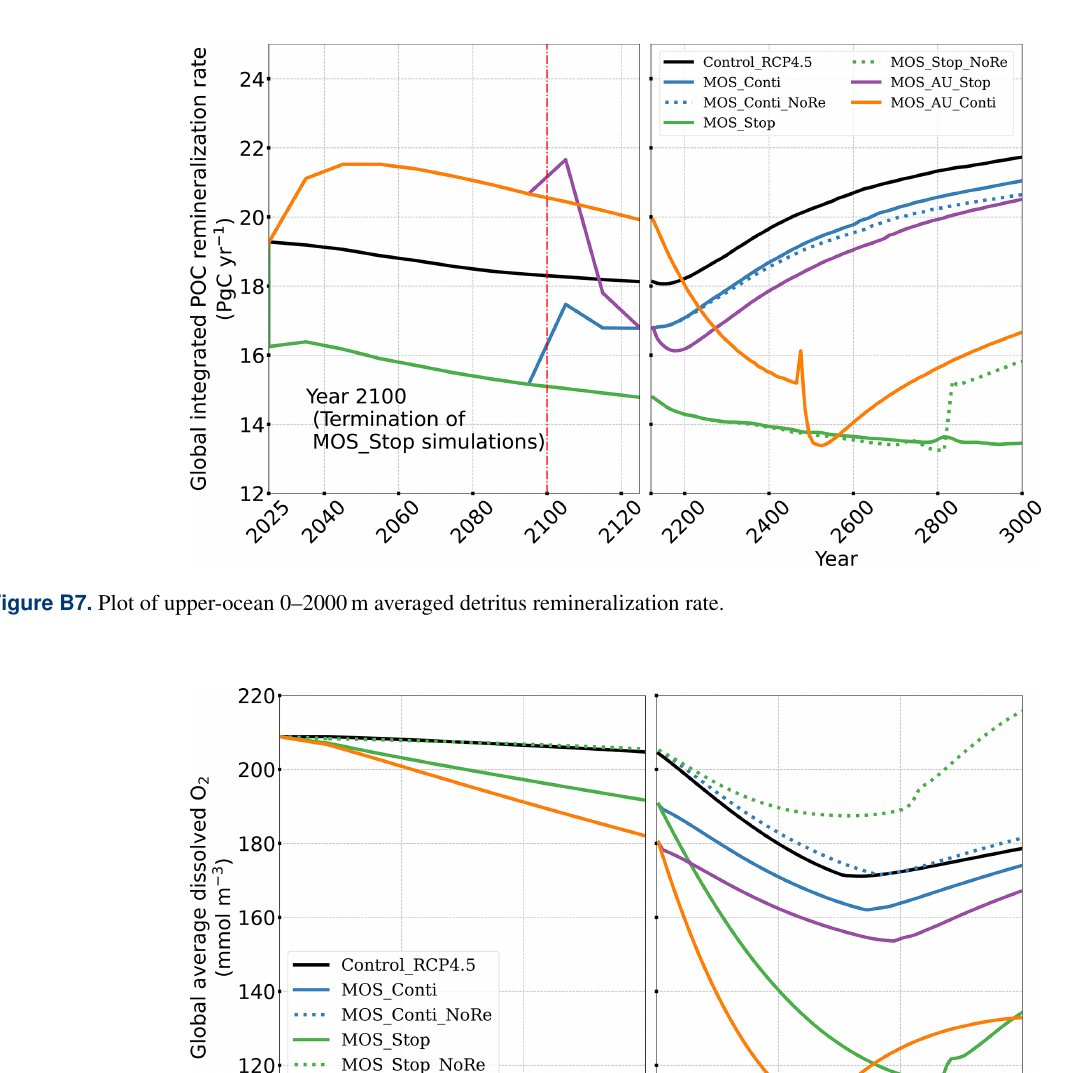
Earth Syst. Dynam., 14, 185–221, 2023